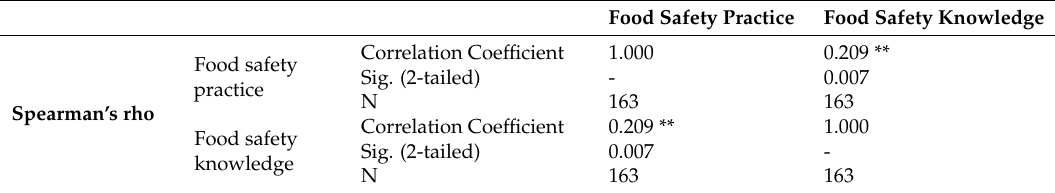
Table 9. Bivariate correlation between food safety knowledge and food safety practices using Spearman rho coefficient.